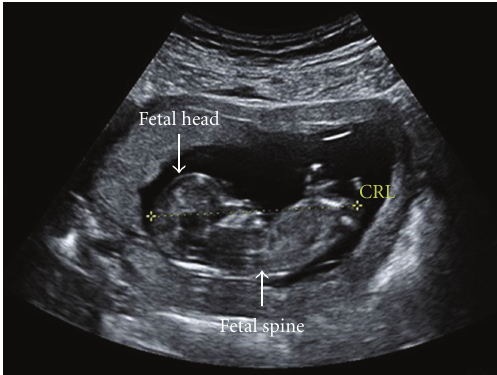
Figure 2: Ultrasound image of a 12-week fetus. The broken yellow line is the crown rump length (CRL)